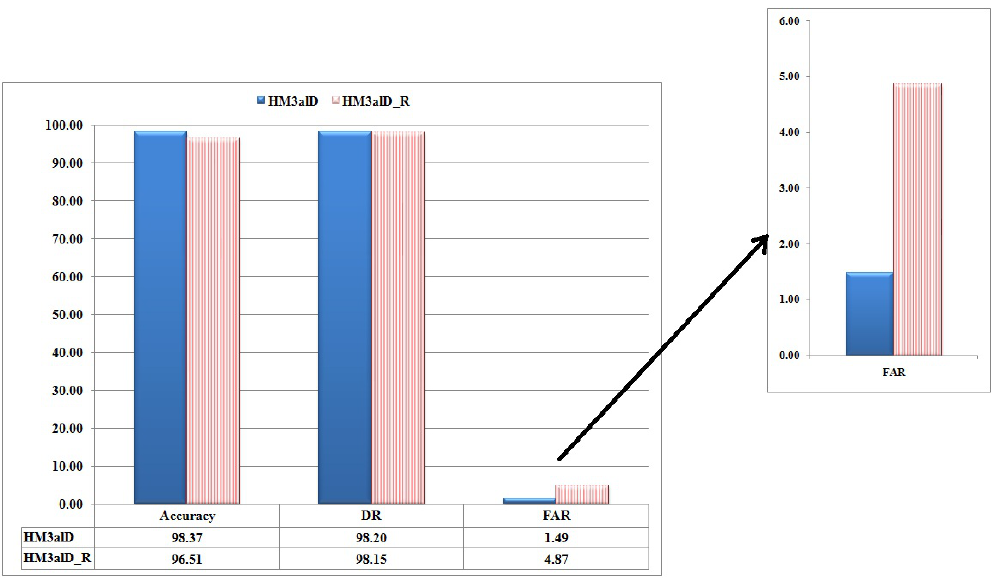
Figure 8. The performance comparison of HM 3 alD with and without the program behavior-aware topology for k = 24 and fracrej = 0.05.